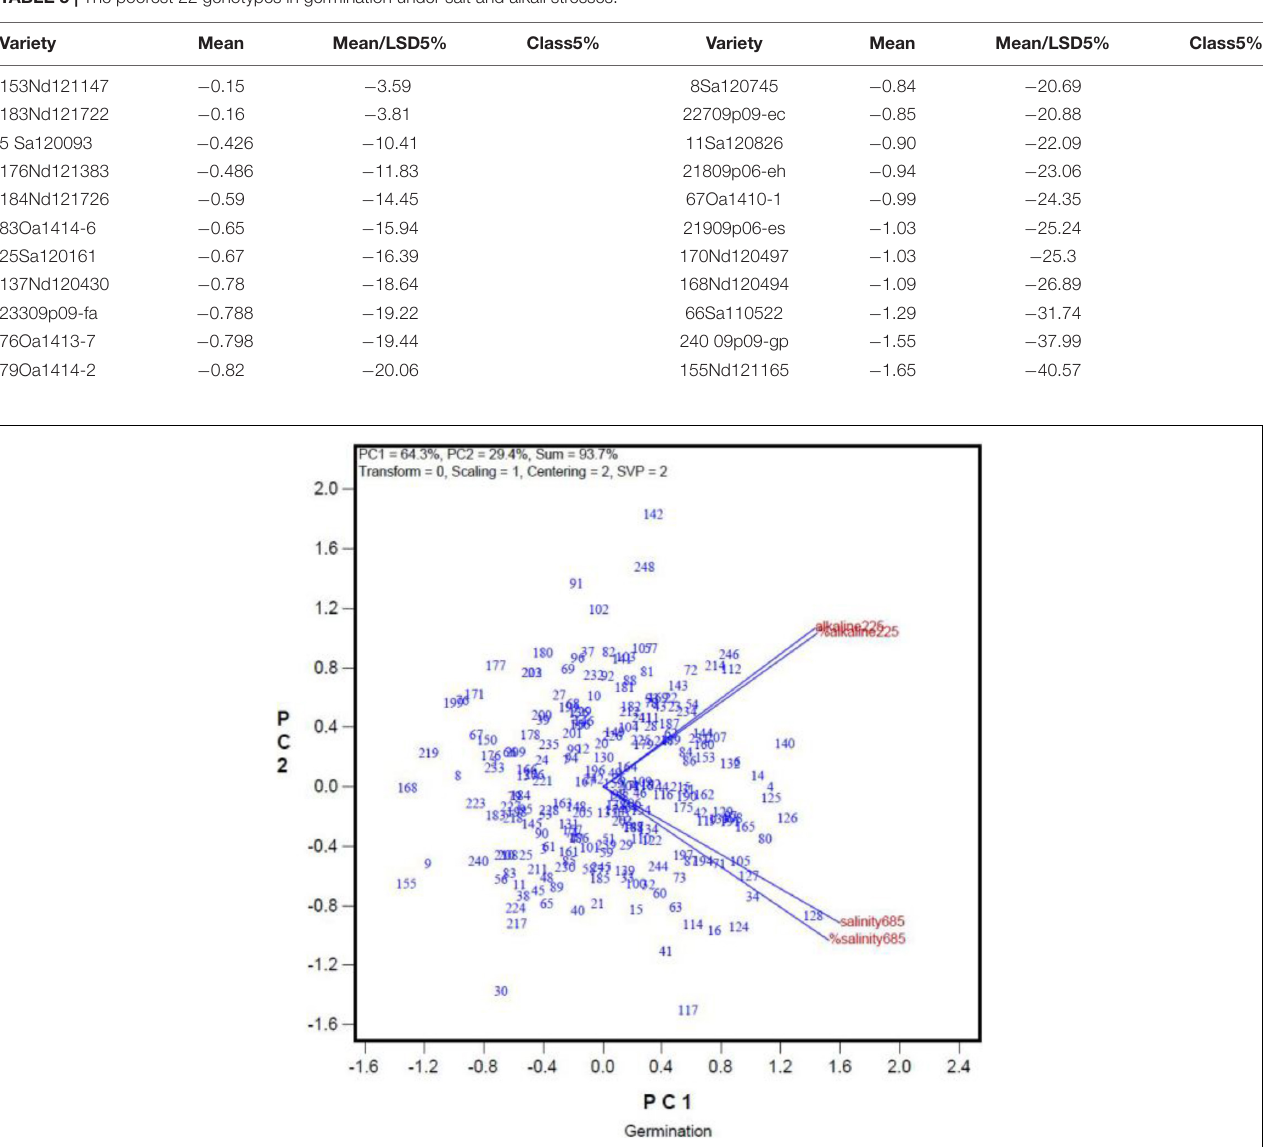
TABLE 5 | The poorest 22 genotypes in germination under salt and alkali stresses.